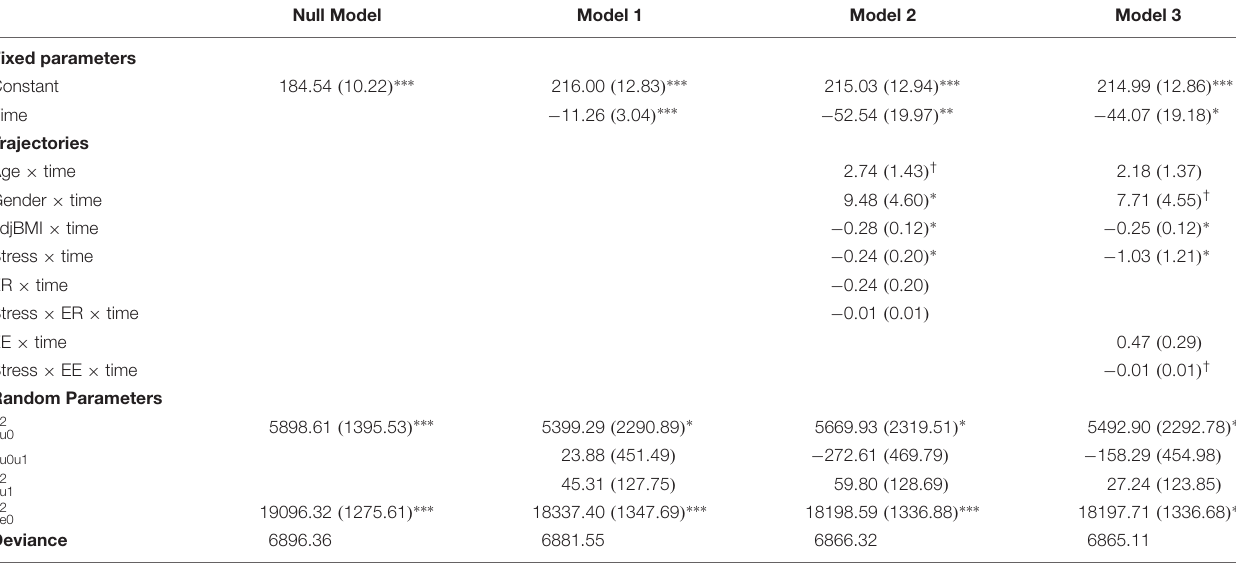
TABLE 5 | Daily snacking as a function of stress, maladaptive emotion regulation, and trait emotional